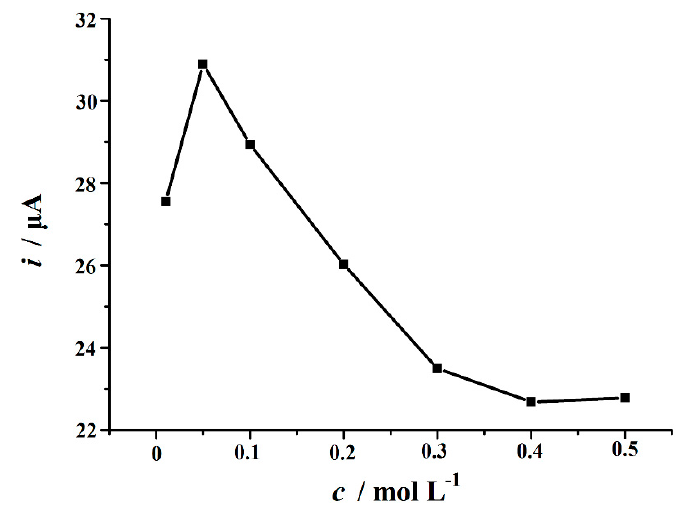
Figure 6. Effect of H 2 SO 4 concentration on the oxidation of 10 μ M Trp on the Cu 2 O ‒ ERGO/GCE.